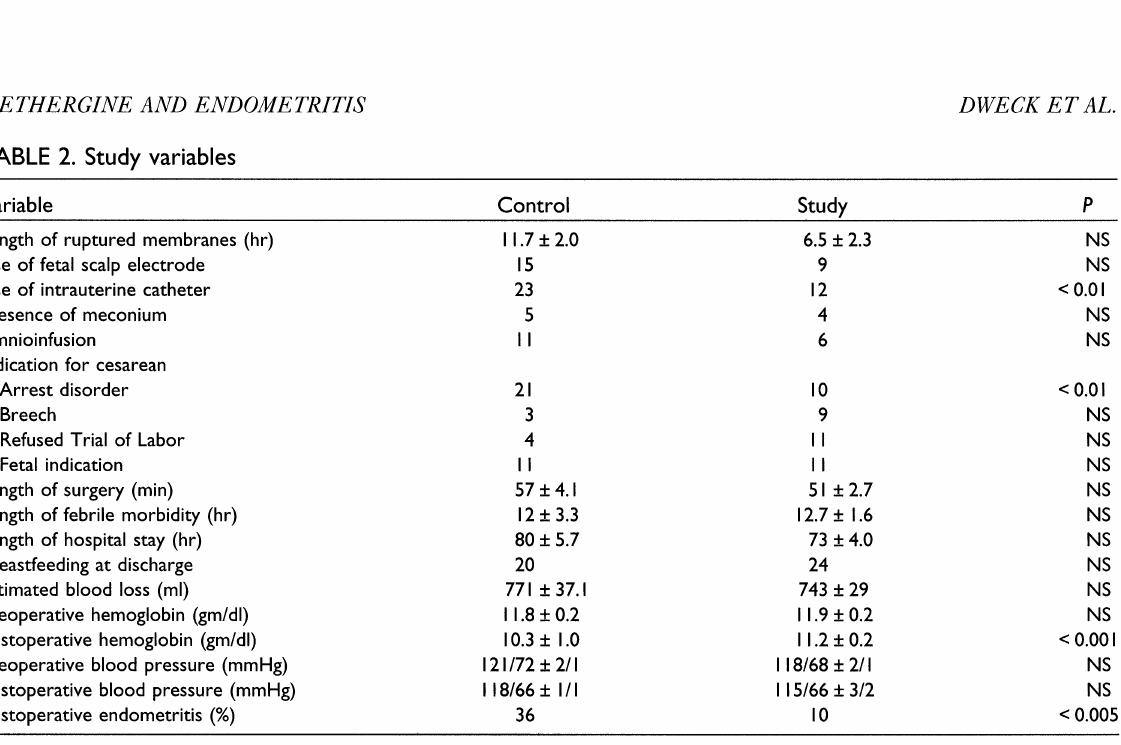
TABLE 2. Study variables Variable Control Length of ruptured membranes